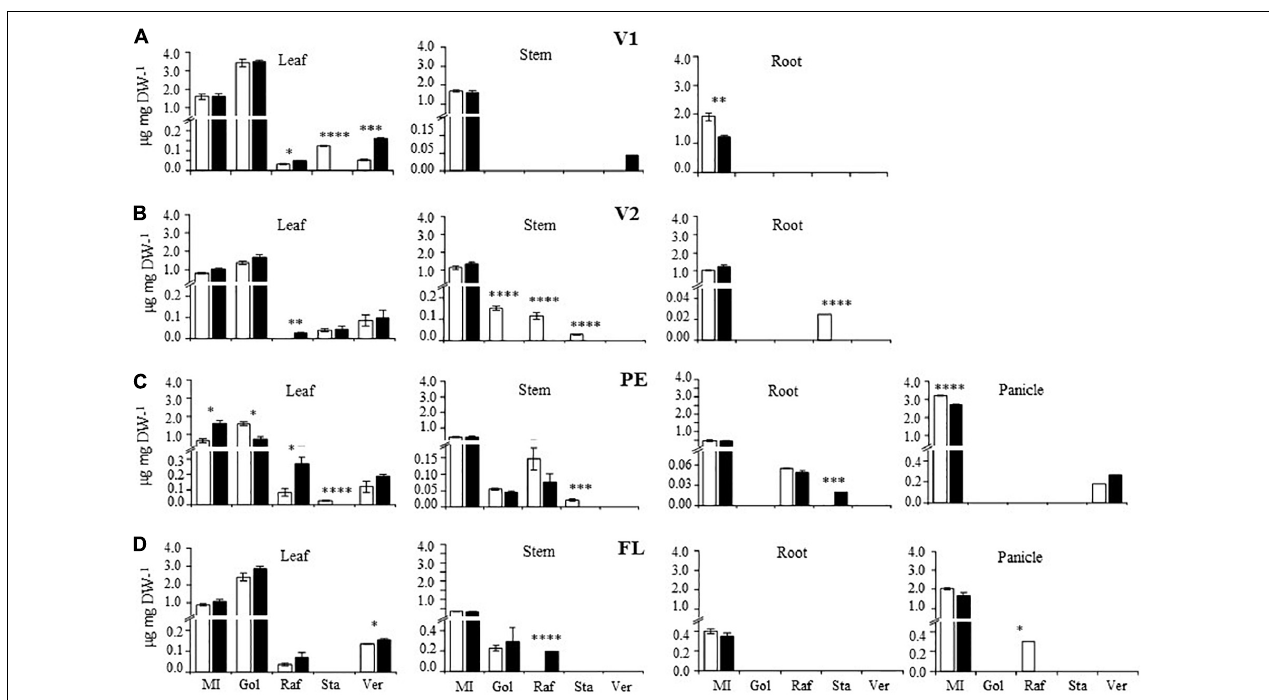
FIGURE 5 | Content of raffinose family oligosaccharides (RFOs) in organs of defoliated versus non-defoliated Amaranthus cruentus plants. Levels of the RFO precursors, myo-inositol (MI), and galactinol (Gol), and of raffinose (Raf), stachyose (Sta), and verbascose (Ver) RFOs were determined in leaves, stems, roots, and panicles of A. cruentus plants subjected to complete defoliation at four different development stages: (A) vegetative 1 (V1), (B) vegetative 2 (V2), (C) panicle emergence (PE), and (D) flowering. The bars represent the means ± standard error of three technical replicates obtained from three pooled plant samples produced by combining organs from nine individual plants. The results are from a representative experiment that was replicated twice. Asterisks indicate statistically significant differences between treatments at ∗ P < 0.05, ∗∗ P < 0.01, ∗∗∗ P < 0.001, or ∗∗∗∗ P < 0.0001 for a one-way ANOVA, Tukey HSD